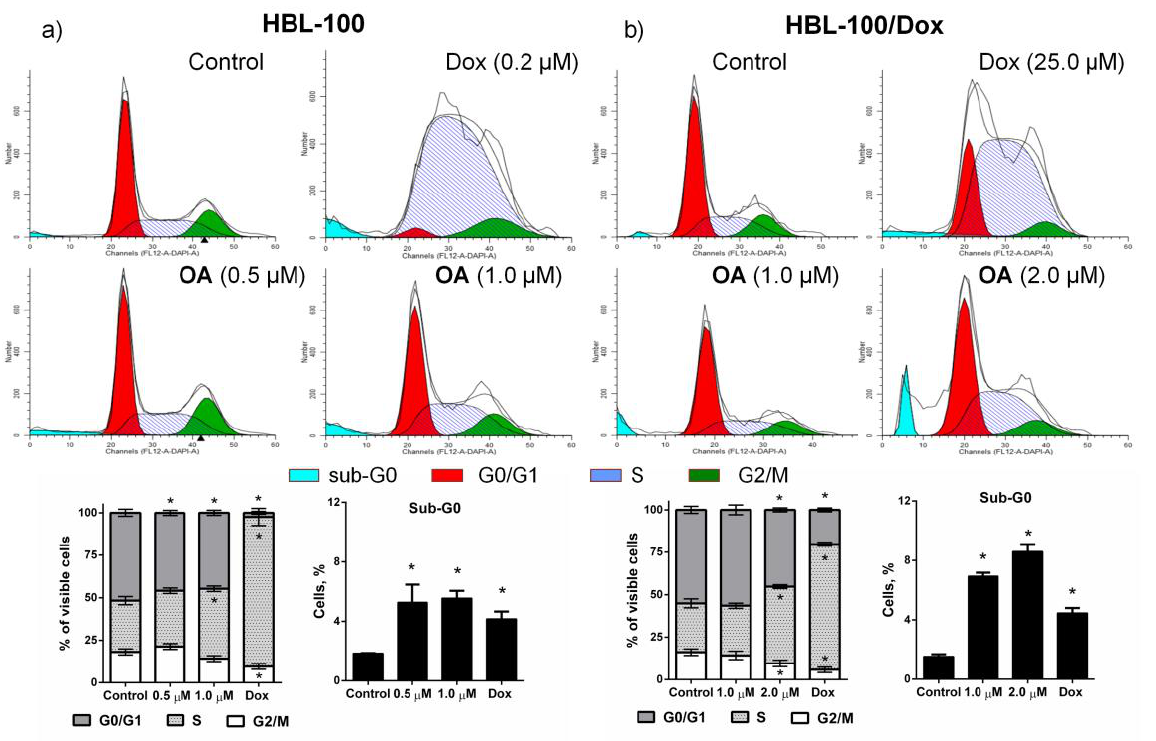
Figure 7. Flow cytometry analysis of the cell cycle phase distribution in cancer cells after treatment with OA or Dox for 16 h: ( a ) HBL-100 cells; ( b ) HBL-100/Dox cells. * Statistical significance of number of cells as compared to control value ( p <